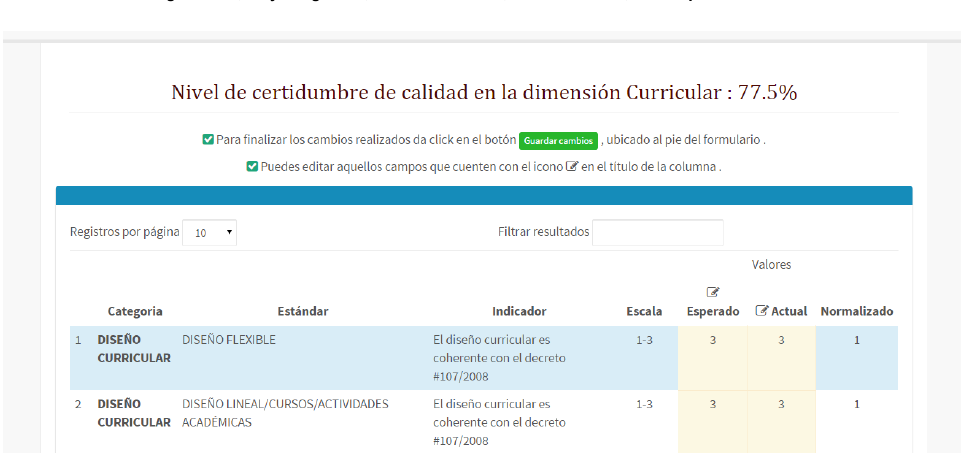
Figure 2 . Computer design of the model of postgraduate quality assurance (Careaga & Meyer, 2013).